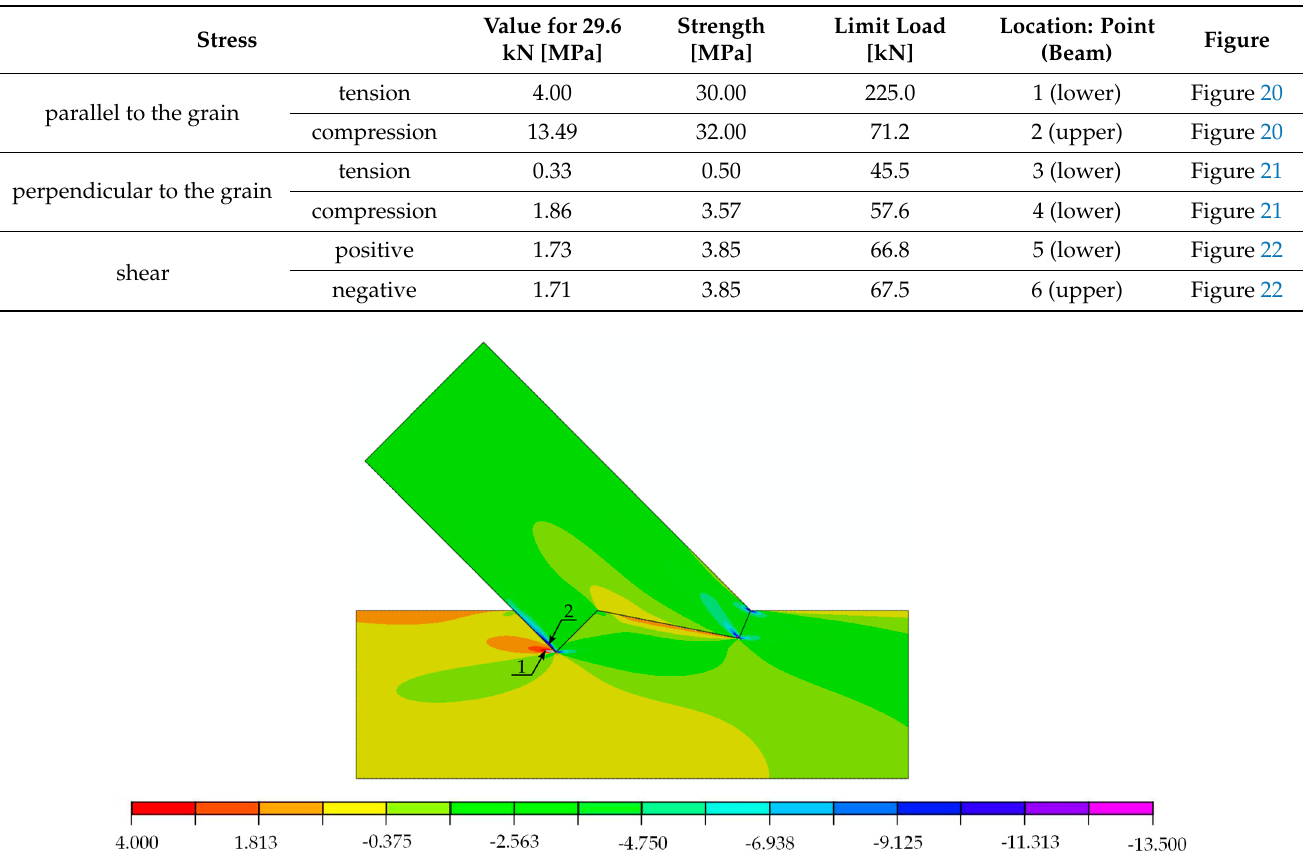
Table 3. Stress values and location at a load of 29.6 kN for the double-step joint including the calculation of the limit load for the individual stress (considering the linear progression).